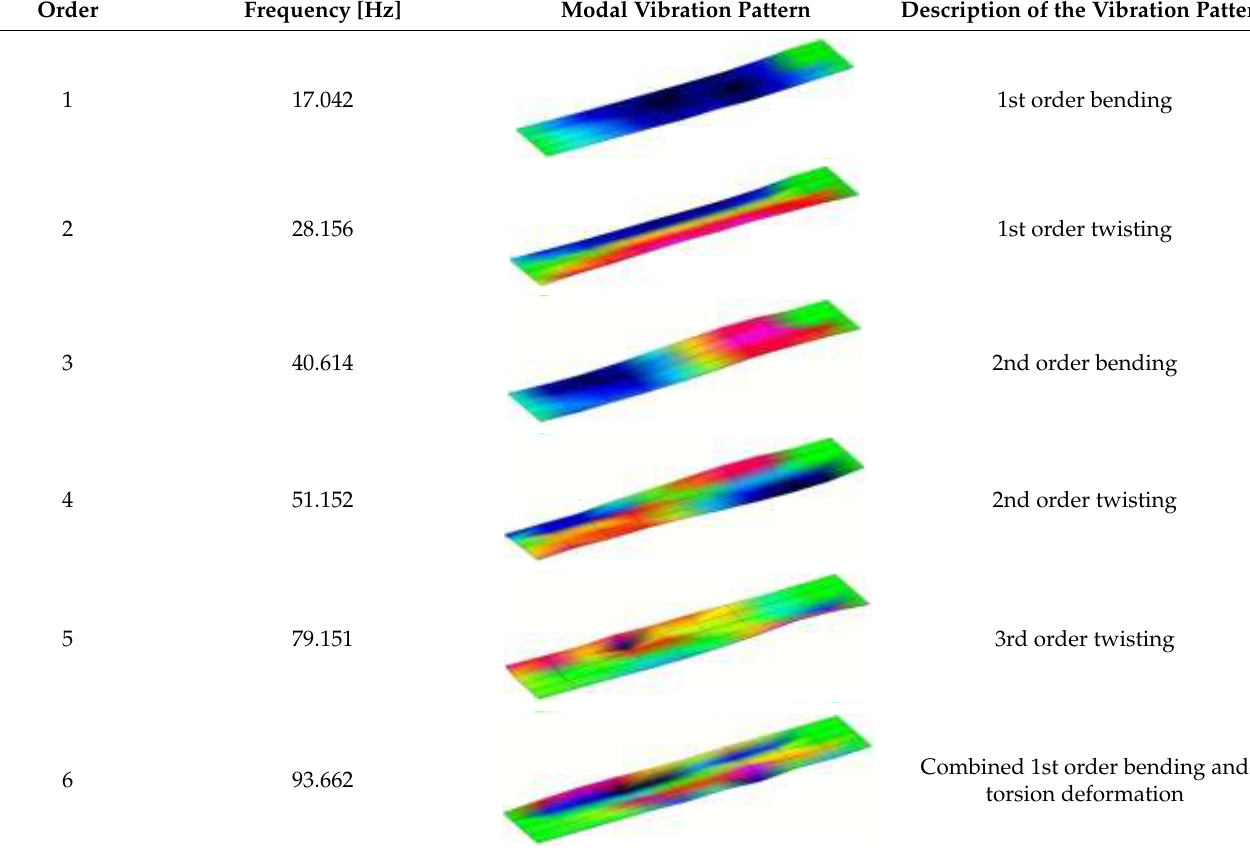
Table 9. Modal frequency and vibration pattern of the bridge deck based on the IPSOARW distri- bution method.